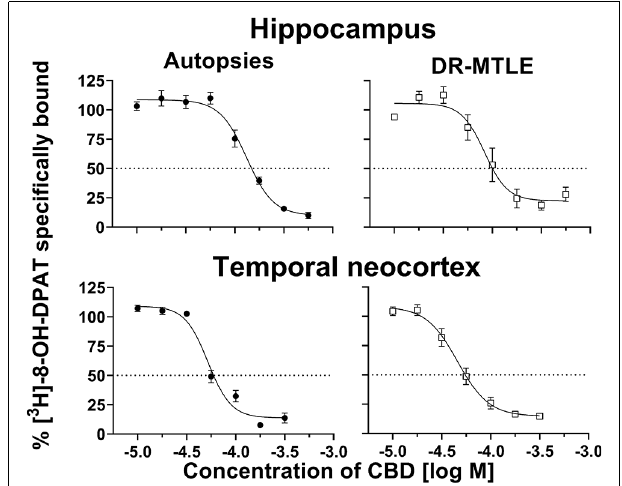
FIGURE 1 | Effects of cannabidiol (CBD) on specific binding of [ 3 H]-8-OH-DPAT to cell membranes obtained from the hippocampus (top panels) and temporal neocortex (bottom panels) of autopsies and patients with drug-resistant mesial temporal lobe epilepsy (MTLE; left and right panels, respectively). Symbols represent the mean ± Standard Error of the Mean (SEM) of five experiments. The dotted lines indicate 50% inhibition of specific binding. Curves were fitted to a model of four parameters (see “Materials and Methods”